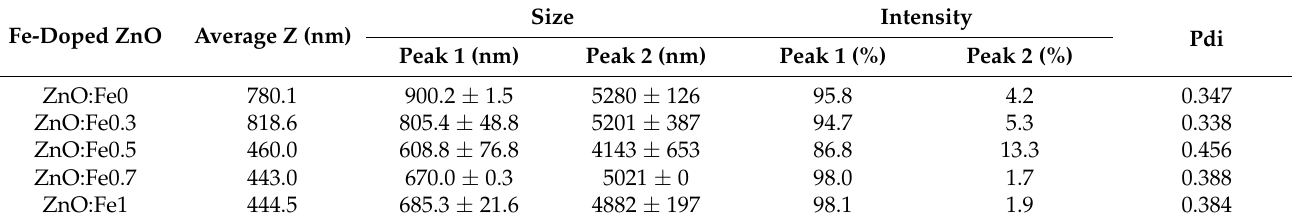
Figure 1. Size distribution of ZnO:Fex nanoparticles. Table 1. Zetasizer parameters for Fe-doped ZnO nanoparticles determined from DLS